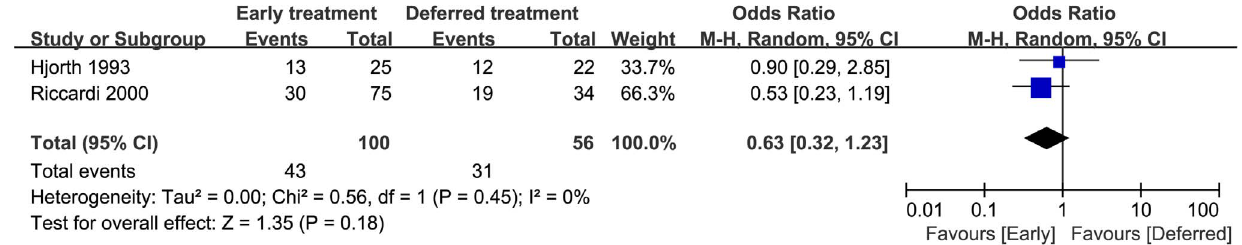
Figure 4. Response rate odds ratios of early treatment versus deferred treatment. Squares on the odds ratios plot are proportional to the weight of each study, which is based on the M-H method. Odds ratios are presents with 95% CIs. CIs, confidence intervals.